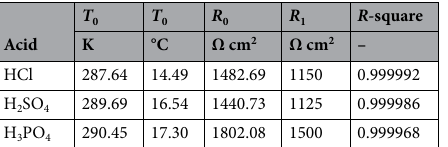
Table 6. Optimal adjustable parameters’ values of Eq. (16) for each acid.